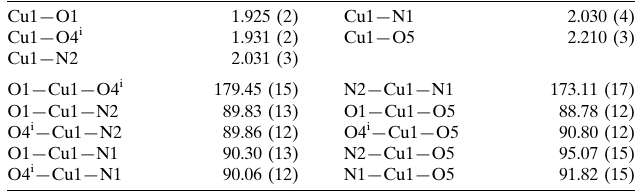
Selected geometric parameters (A˚ , (cid:3) ).